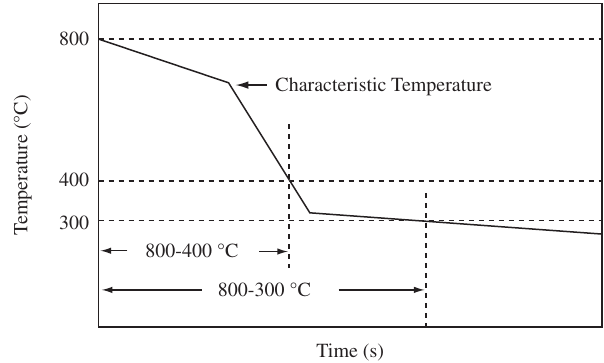
Figure 9. Illustration of important characteristic temperatures for cooling curves obtained by the JIS K 2242 silver probe method.